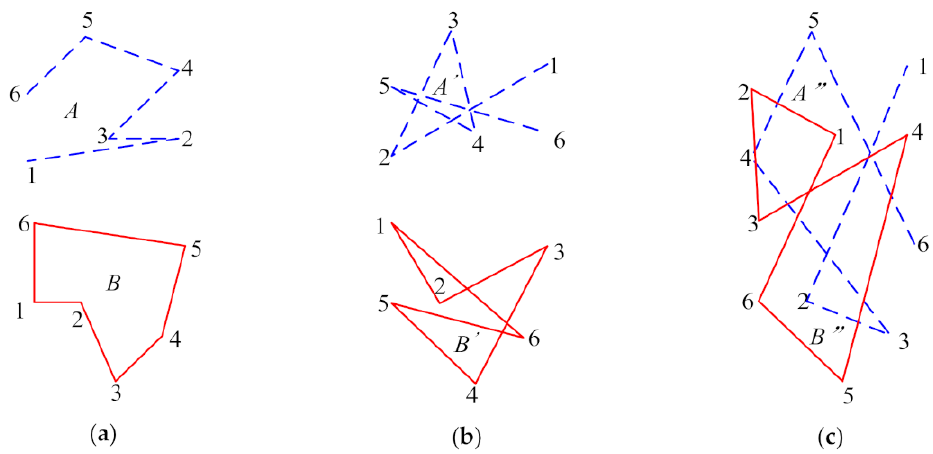
Figure 3. The vector map scrambling principle. ( a ) Original data; ( b ) scrambling in same object; ( c ) global object